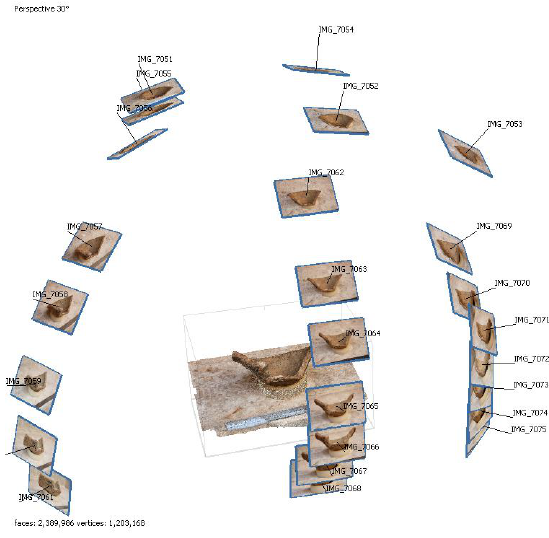
Figure 9. The camera position of separated images by documentation of the bowl from Qala Shila; processing of separated images gave better results due to reduced noise in the data (the point cloud from selected images)